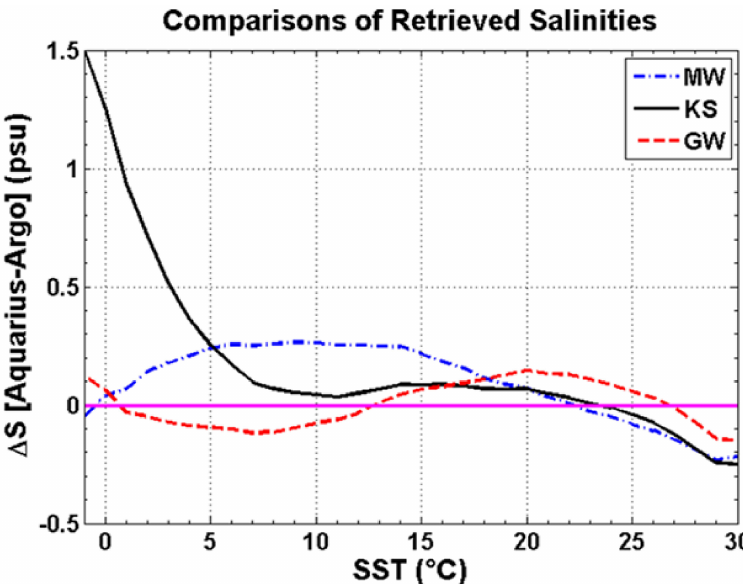
Figure 9. Salinity error as a function of sea surface temperature, SST, when using three different model functions for the dielectric constant of sea water in the retrieval. The three model functions are: Klein–Swift [25], Meissner–Wentz [26], and George Washington University [36]. (Author’s figure from Zhou et al.